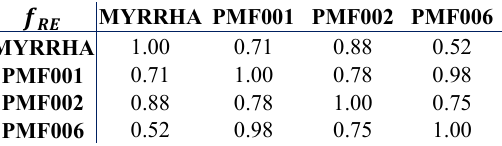
- JEZEBEL (PMF001) [18]: bare sphere of 239 Pu metal, sensitive to 239 Pu; - 240 Pu JEZEBEL (PMF002) [19]: bare sphere of 239 Pu metal with 20.1 at% 240 Pu,